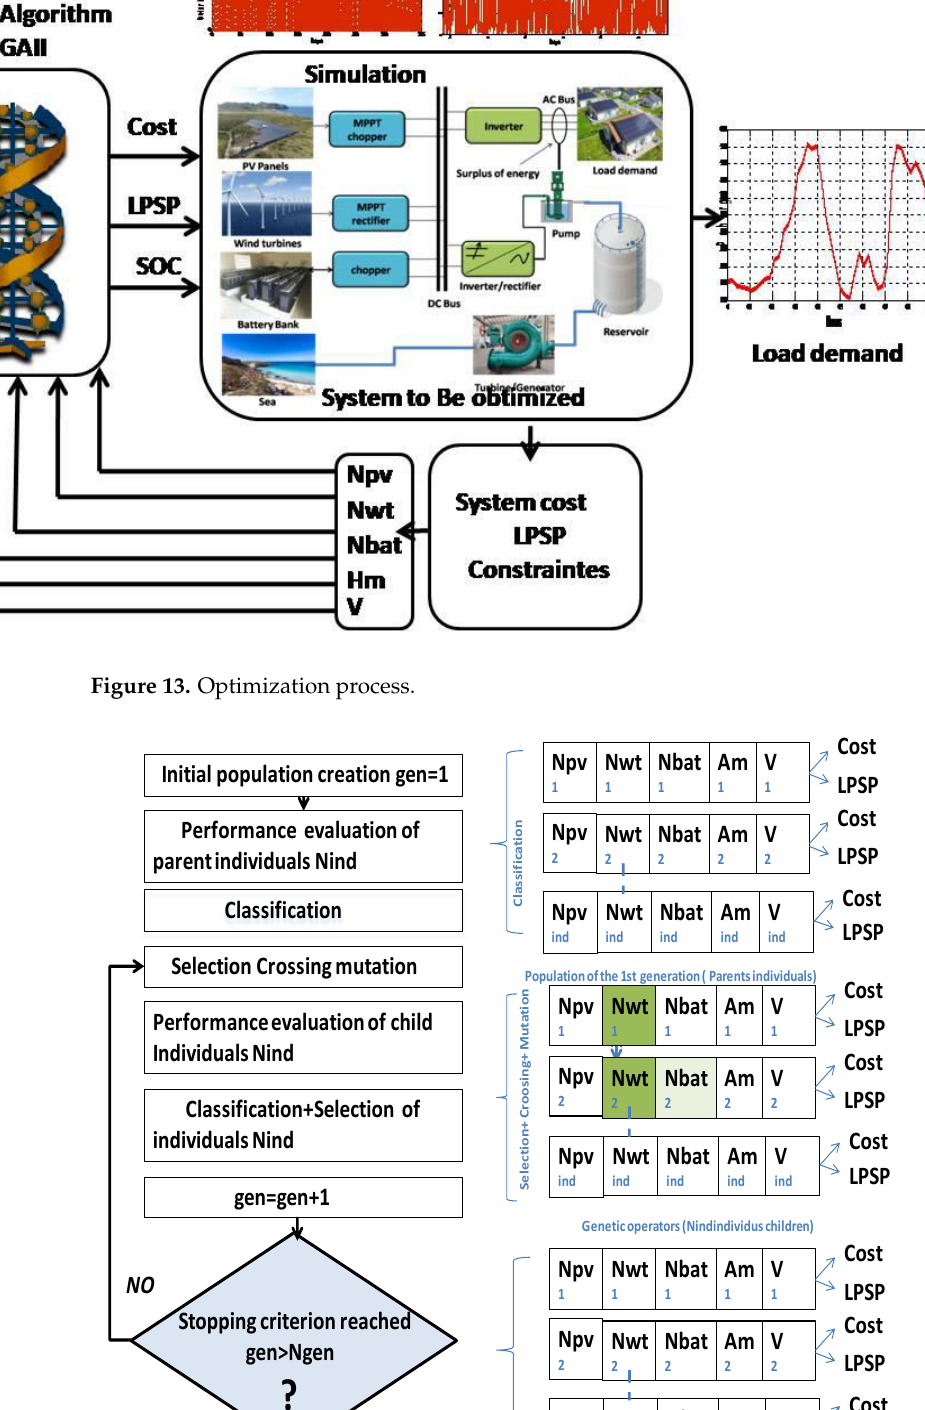
Figure 14. Evolution of the population of individuals during the execution of the NSGA-II genetic algorithm.